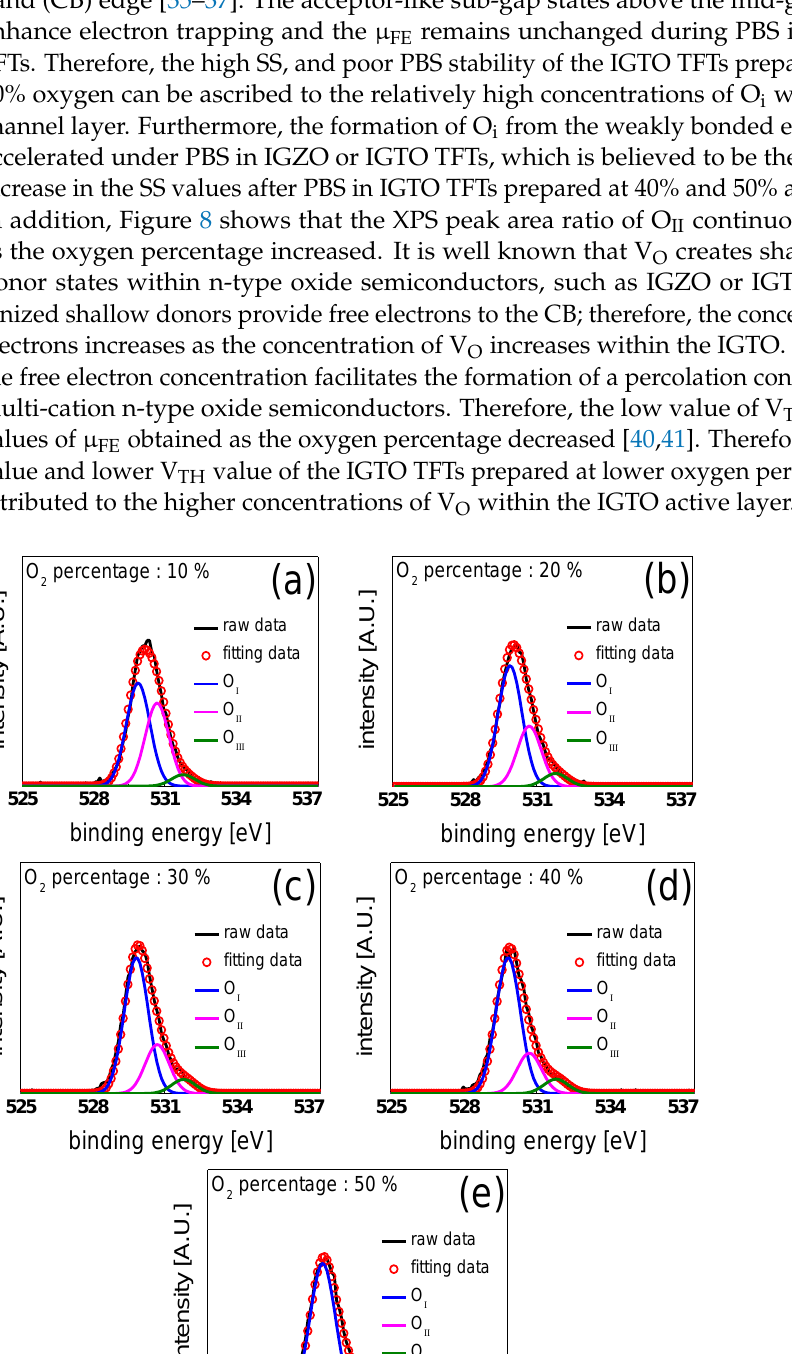
Figure 8. XPS peak area ratios corresponding to O I , O II , and O III , obtained from the IGTO thin films prepared at different oxygen percentages in the sputtering ambient. 10